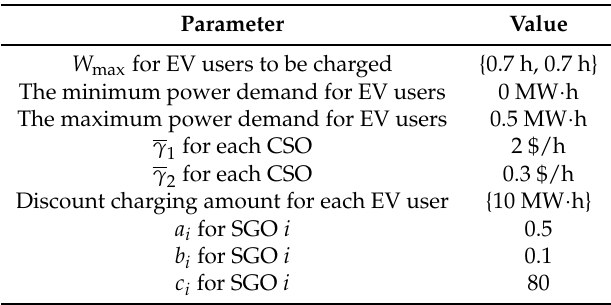
Table 1. Simulation parameters.